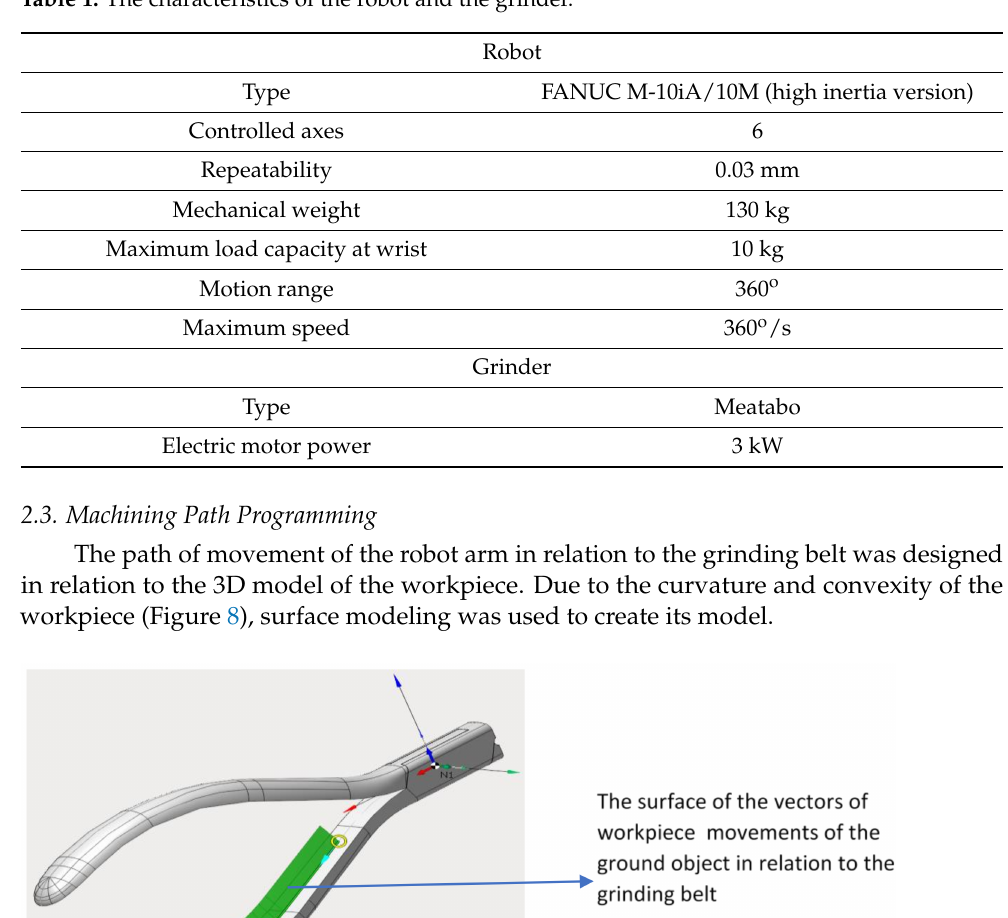
Table 1. The characteristics of the robot and the grinder.